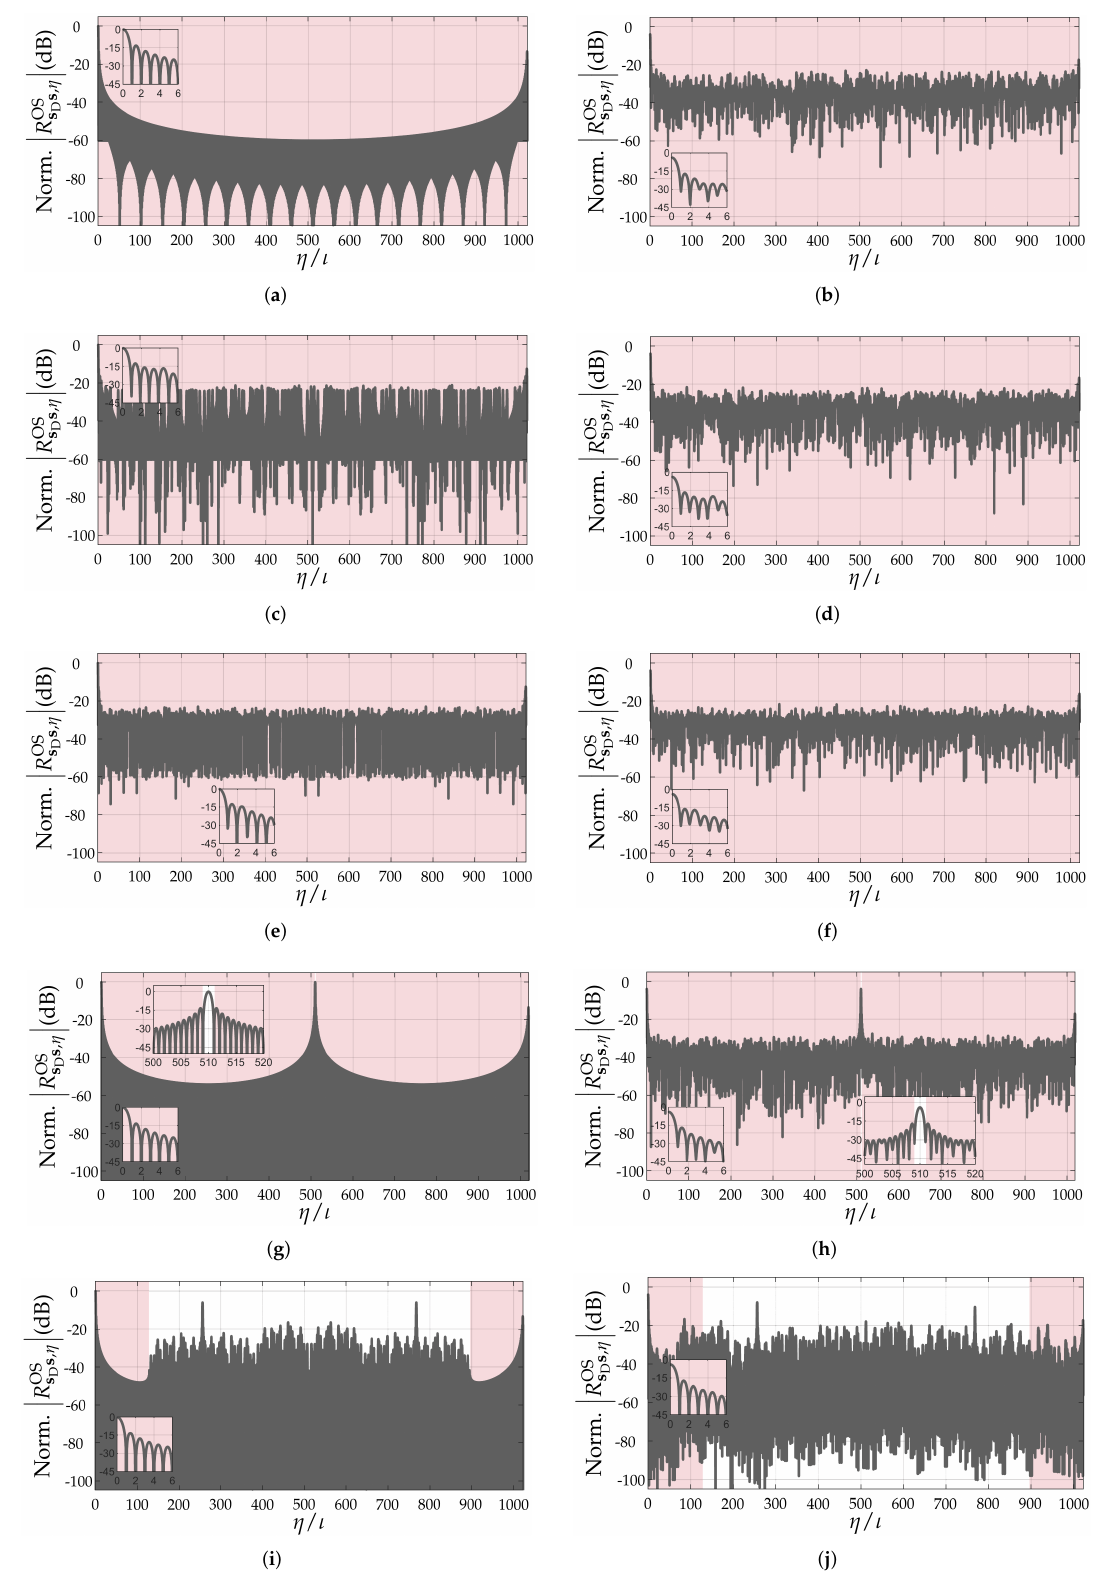
Figure 6. Normalized oversampled PACFs ( ι = 20) under f D / ∆ f = 0 and | f D / ∆ f | = 0.5 of ( a , b ) m-sequence, ( c , d ) Gold sequence, ( e , f ) Kasami sequence, ( g , h ) APAS, and ( i , j ) ZCZ sequence. An with approximate length of N PRBS = 1024 was adopted for all PRBSs. The relevant PACF intervals de- scribed in Section 3 are highlighted in